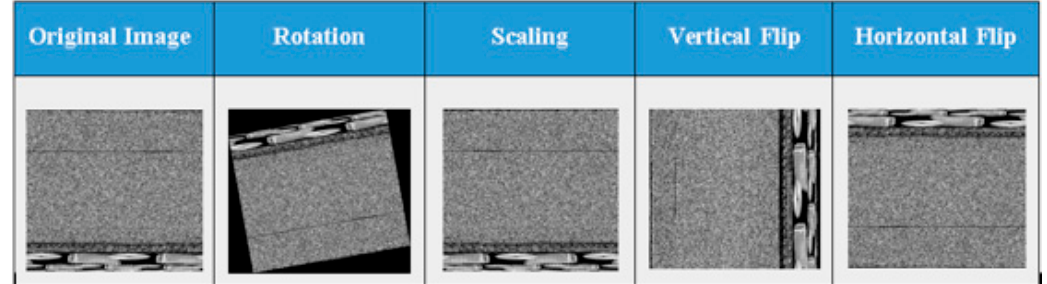
Figure 3. Data augmentation process. Images are generated after applying augmentation techniques on the Swizzor.gen! malware family from the Malimg dataset [51].